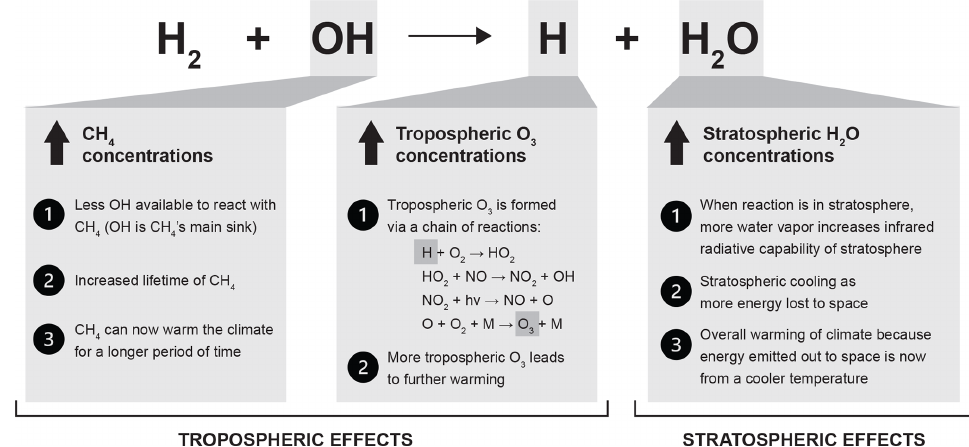
Figure 1. Effects of hydrogen oxidation on atmospheric greenhouse gas concentrations and warming.